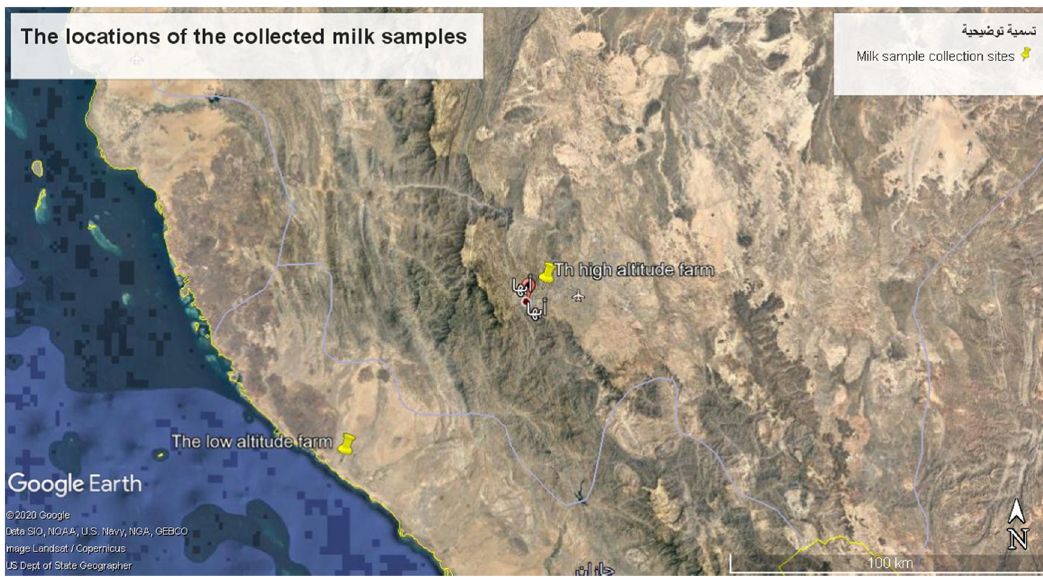
Figure 1: Sample collections sites. The milk samples were collected from two farms located at two di ff erent altitudes: 14 m above sea level and 2,110 m above sea level. The fi gure was created from the Google earth program at: